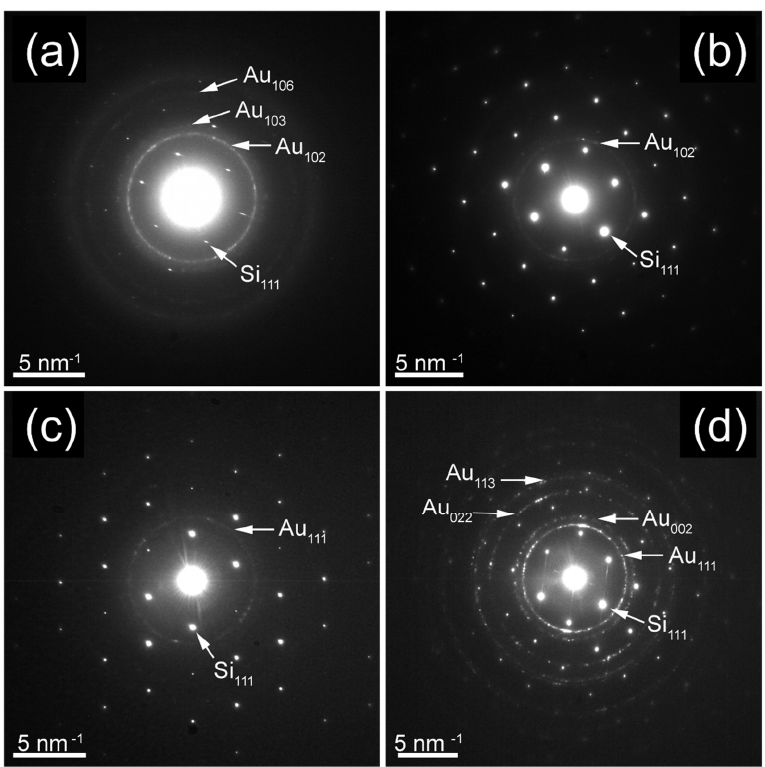
Figure 2. SAED patterns of sample ( a ) Au 70 Fe 30 _70, ( b ) Au 70 Fe 30 _17, ( c ) Au 70 Fe 30 _6, and ( d ) Au 80 Fe 20 _70.